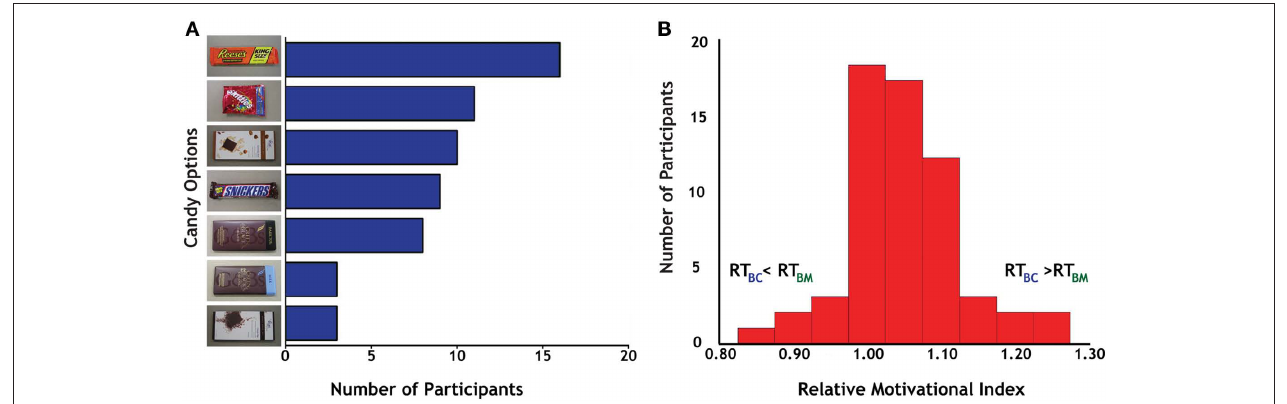
all seven options were chosen by multiple participants, indicating a distribution of candy preferences in the participant sample. (B) Distribution of the relative motivational index (RMI), calculated as the ratio of reaction times on successful Big Candy (BC) and Big Money